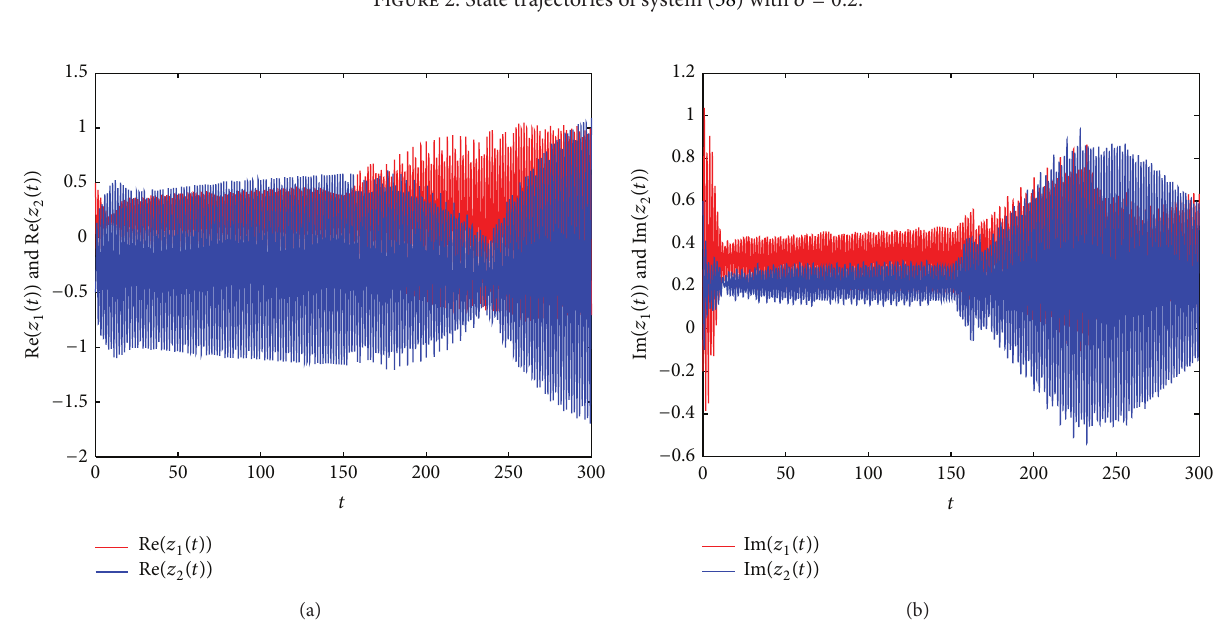
Figure 3: State trajectories of system (58) with 𝛿 = 0.37